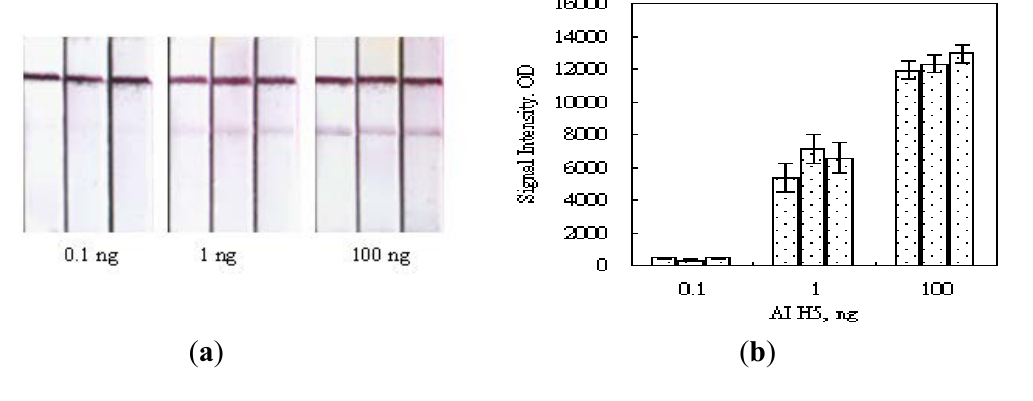
Figure 10. The repeatability of the MBLF strips with a voltage applied. Three replicate strips were use in the experiment for three different doses of H5 AIV analyte, 0.1, 1, and 100 ng. 12 V current was applied to all